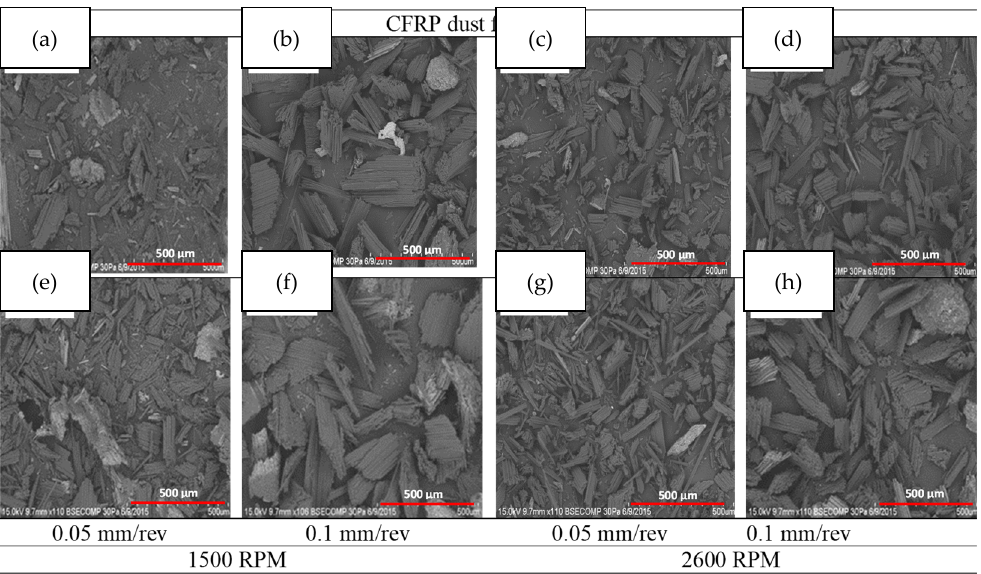
Figure 11. Dust characteristics of CFRP depending on tool geometry parameters and cutting parameters: ( a – d ) Point angle of 110°, ( e – h ) Point angle of 130° [95].